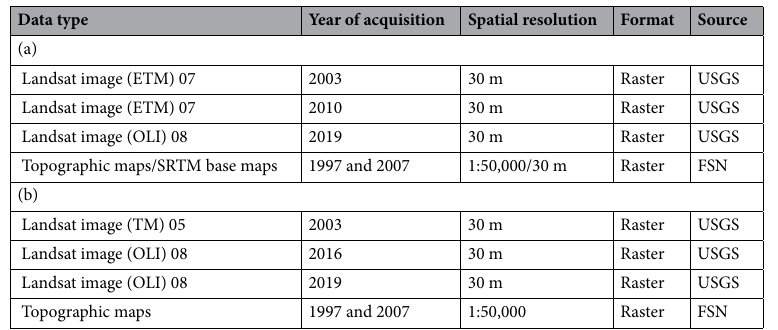
Table 1. Datasets used for the LULC analysis for (a) the entire study area and (b) Reach 3 area. USGS United States Geological Survey, FSN Federal Surveys of